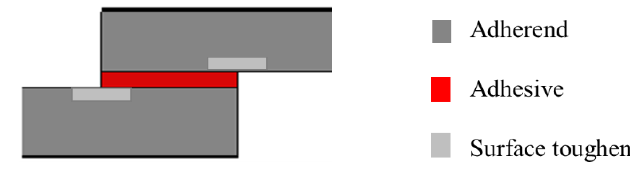
Figure 27. Localised surface toughening concept. Adapted from [161].